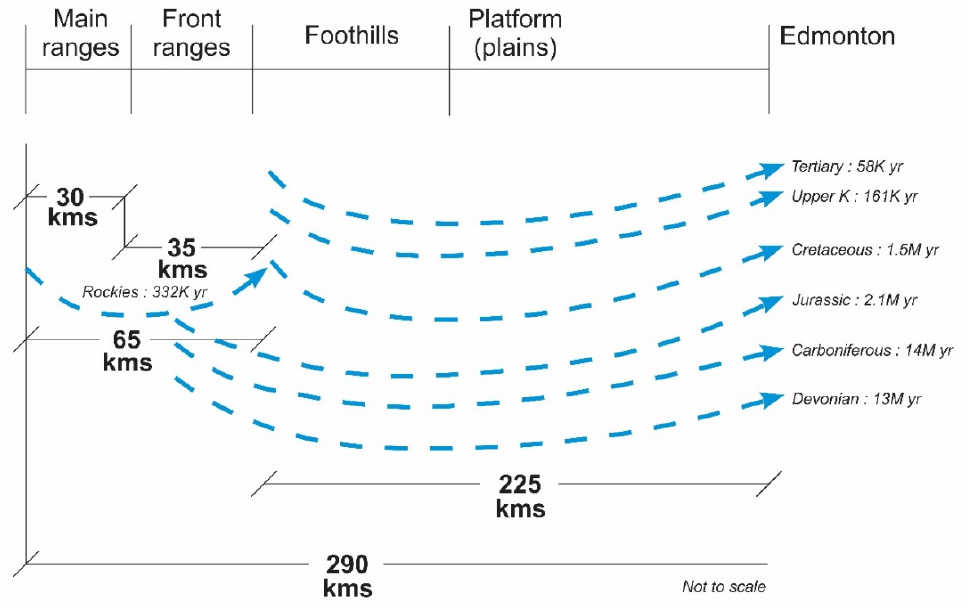
Figure 22. Transient times to reach near steady state condition.